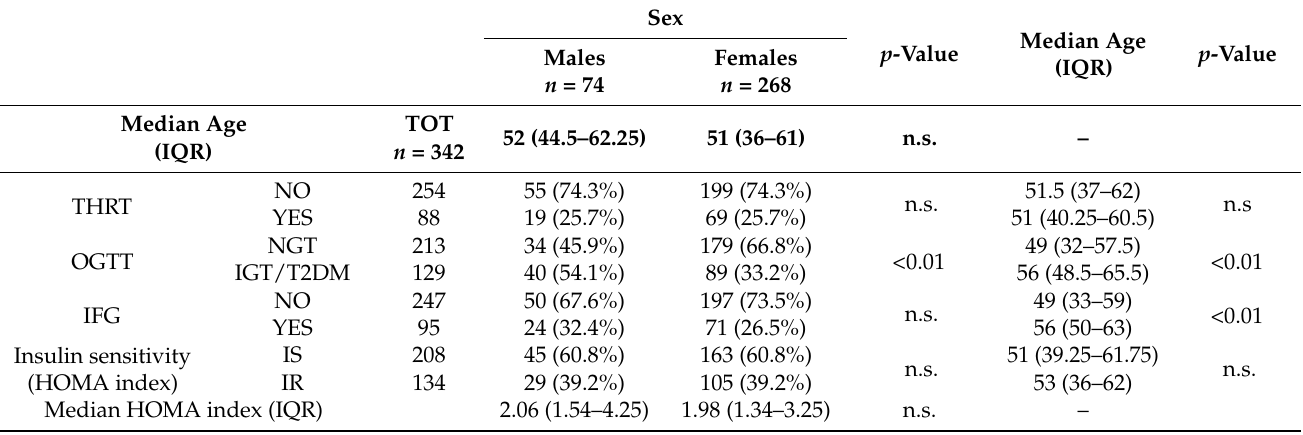
Table 1. Distributions of age, THRT, OGTT categories, FPG categories, insulin resistance and HOMA index in males vs. females. Percentages refer to the population of the corresponding sex. Mann– Whitney test was used to analyze age of each nominal